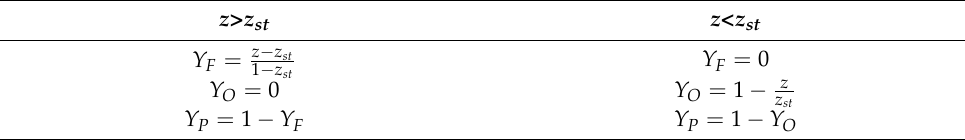
Table 6. Burke–Schumann